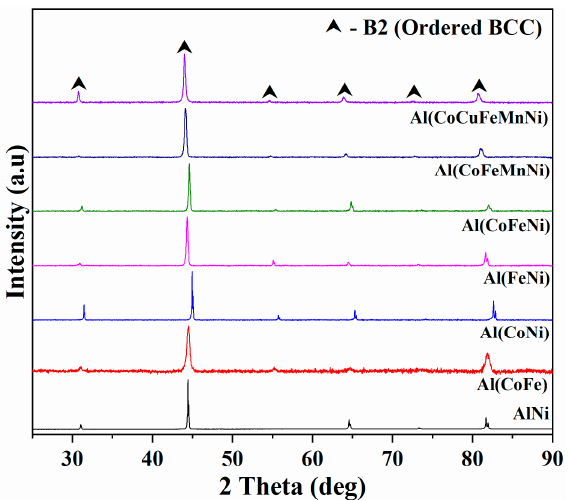
Figure 15. X-ray di ff ractograms of pseudo-binary multicomponent alloys annealed at 1073 K for 200 h Figure 15. X-ray diffractograms of pseudo-binary multicomponent alloys annealed at 1073 K for 200 showing the ordered BCC (B2) h showing the ordered BCC (B2) structure.